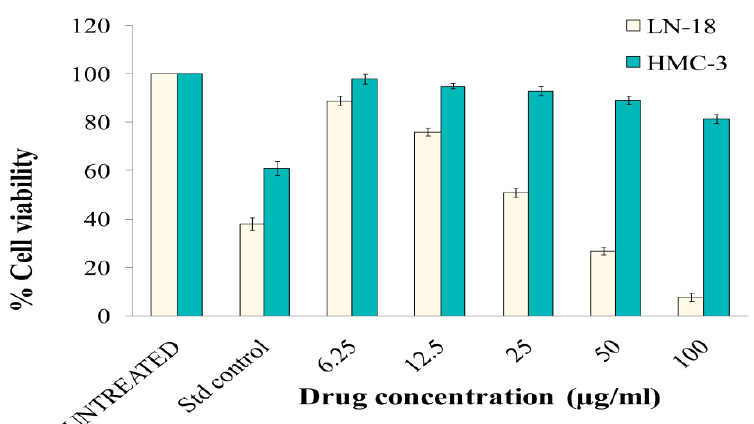
Figure 9. Cell viability (%) of LN-18 and HMC-3 cells treated with N-ZnO Ps.